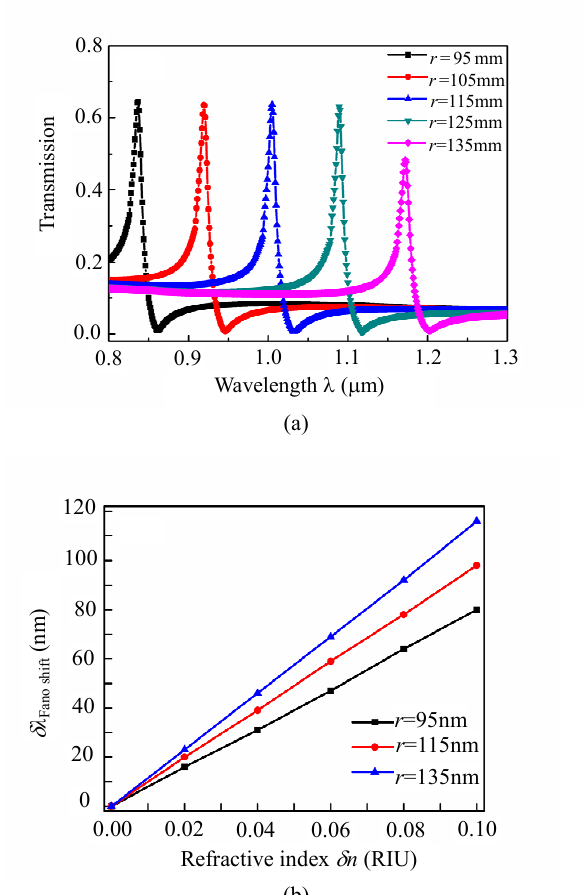
Fig. 4 Transmission spectra of the MIM waveguide coupled with two rings and rectangular cavities with (a) different r and (b) shift in the Fano resonance peak as a function of the refractive index δ n . Here, r = r ′ and n =